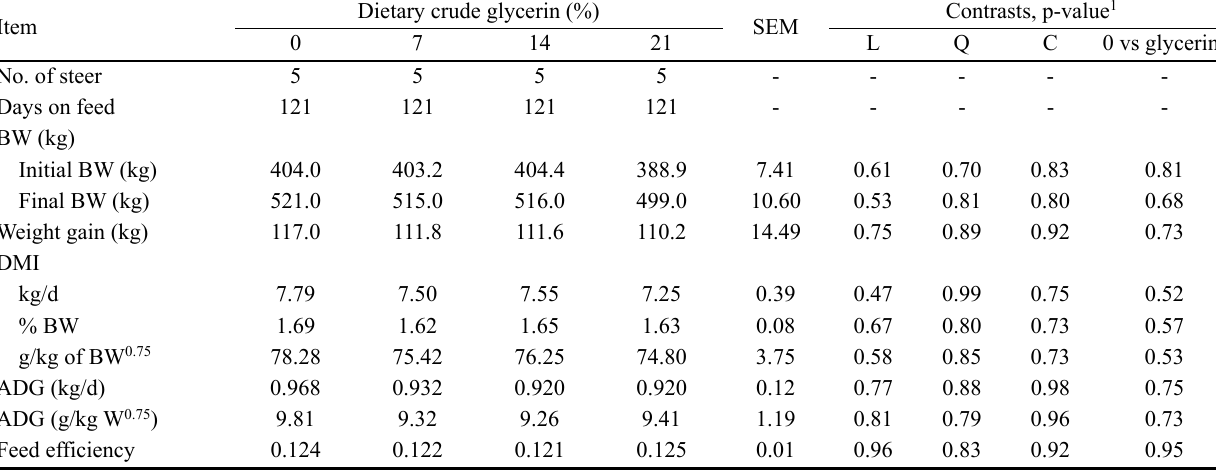
Table 3. Effects of dietary crude glycerin on performance and DMI of finishing steers